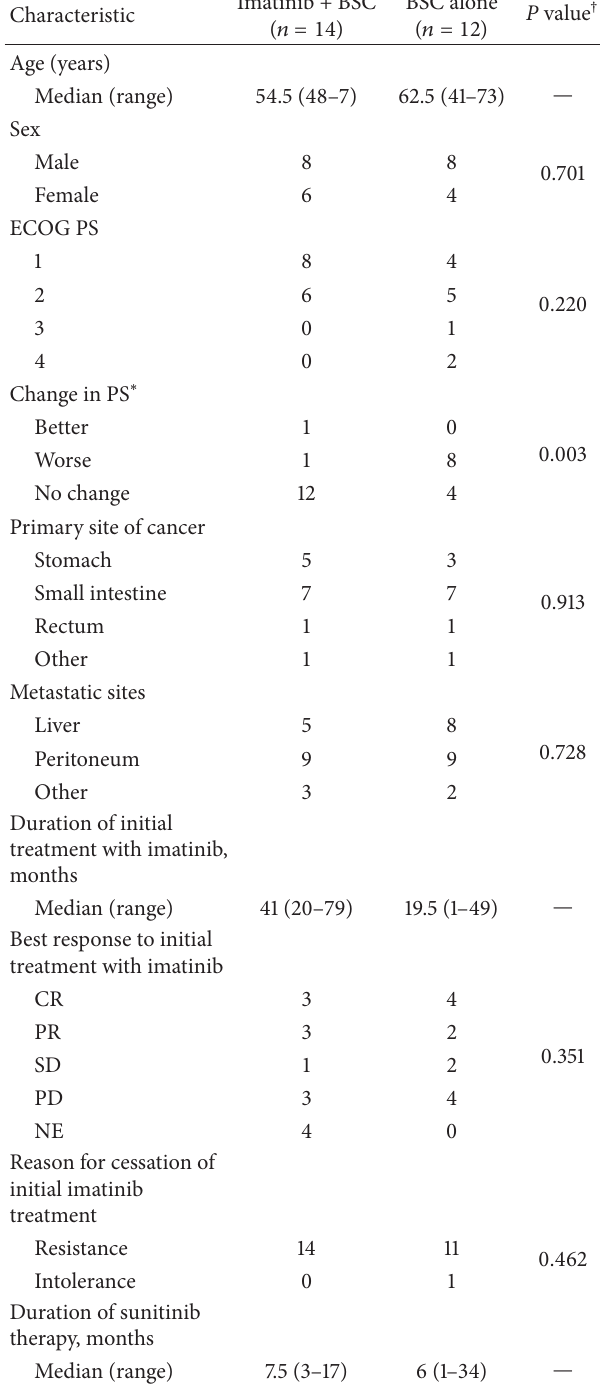
Table 1: Baseline